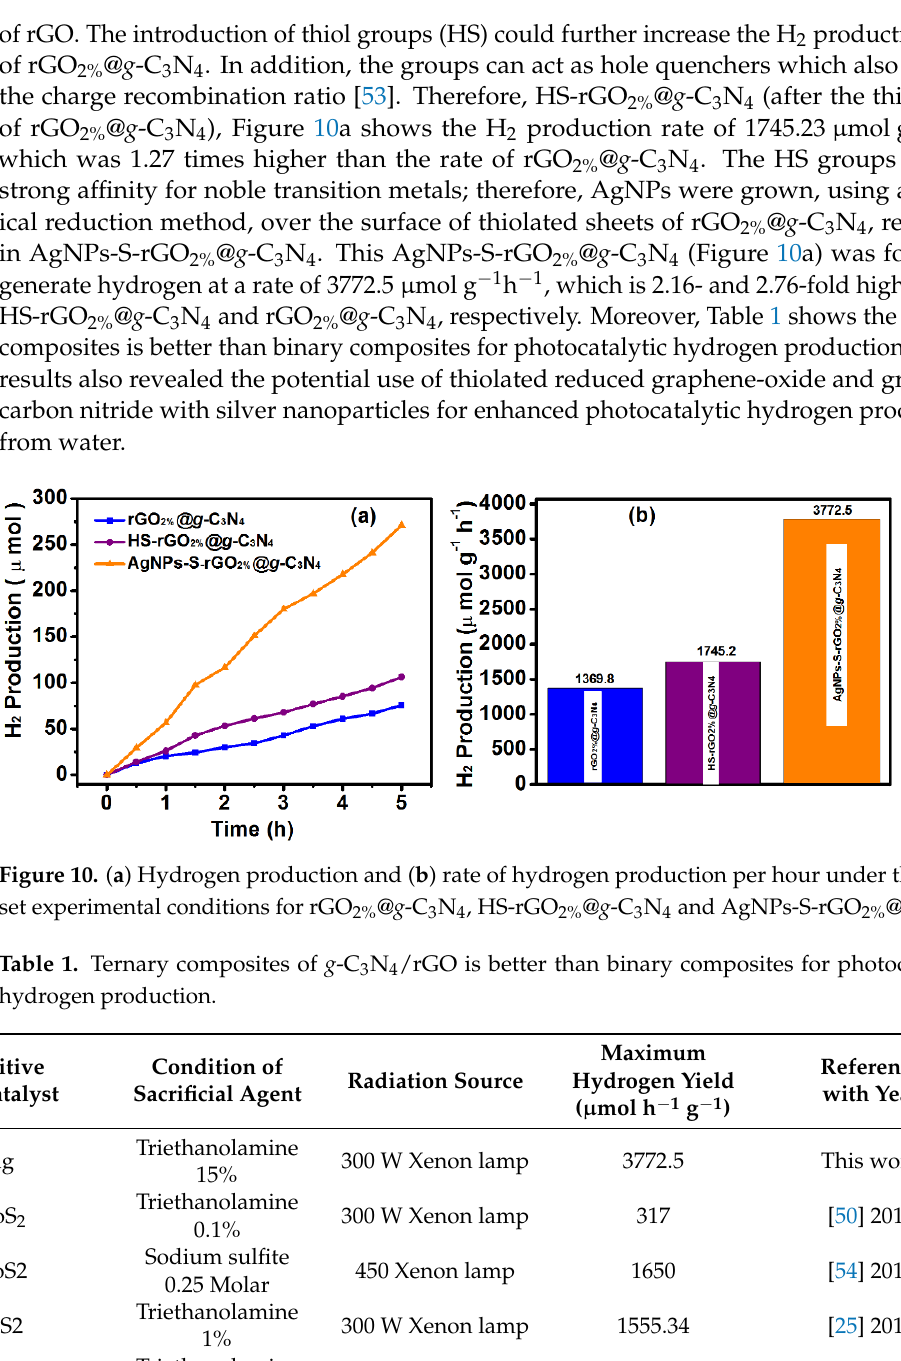
Figure 11. ( a , b ) Reusability and stability of AgNPs-S-rGO 2% @ g -C 3 N 4 for four consecutive cycles.